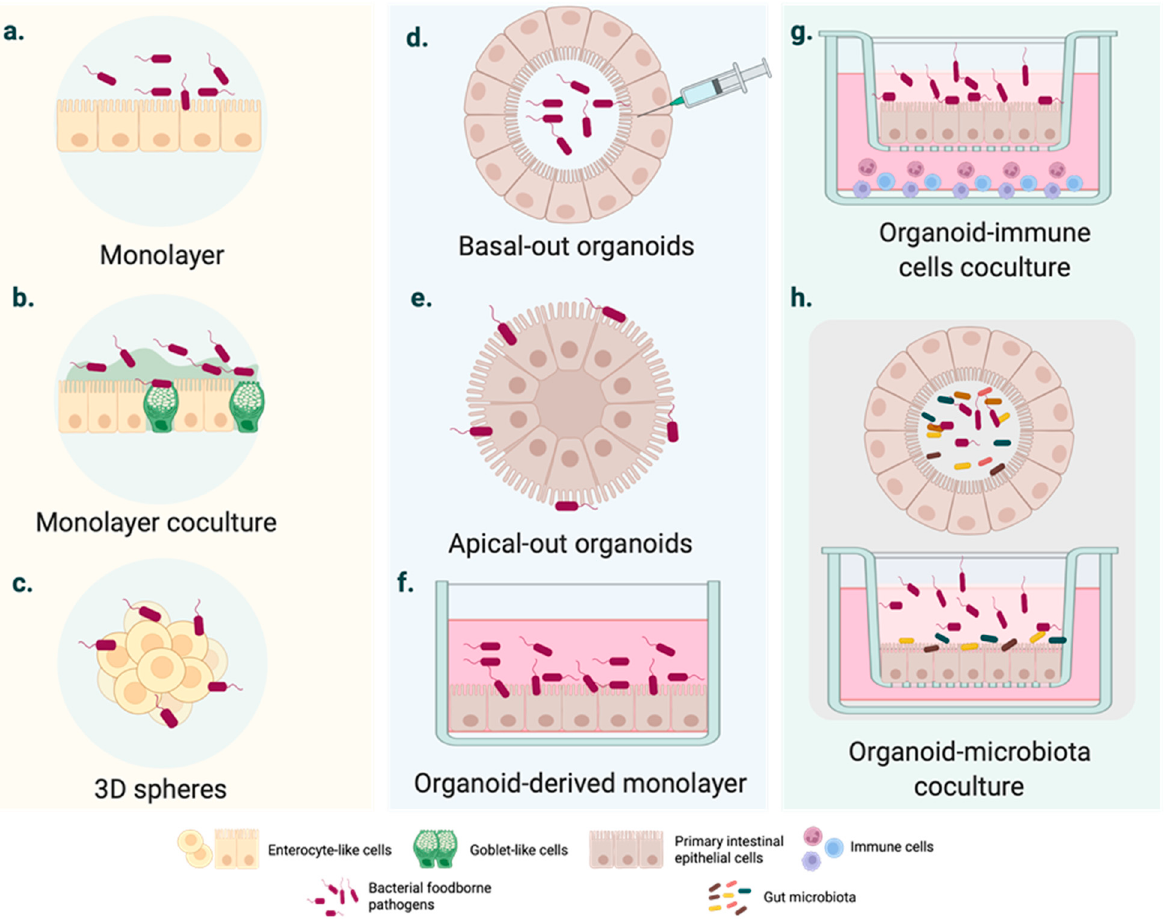
Figure 1. Cell culture systems mimicking intestinal FBD. ( a – c ) Intestinal FBD models derived from immortalized cells. ( a ) Polarized homogeneous cell monolayer typically based on immortalized cell lines with an enterocyte-like phenotype (e.g., Caco-2 cell monolayer). ( b ) Heterogeneous cell monolayer coculturing different cell lines to mimic essential intestinal features, such as the mucus- carrying intestinal tissue (e.g., Caco-2 and HT29 co-culture in vitro cell models). ( c ) 3D cell spheres developed from tumor-derived cell lines. ( d – f ) Intestinal organoid cultures generated from pluripo- tent stem cells (PSCs) or adult stem cells (AdSCs). ( d ) Basal-out organoid. The pathogen is generally injected inside the organoid. ( e ) Apical-out organoids might enhance the access of FBP with a high preference for the apical intestinal compartment. ( f ) Organoid-derived monolayers are D cell infection systems, such as the conventional immortalized cell cultures. ( g – h ) Coculture of intestinal organoids with immune cells and microbiota. More sophisticated organoid-based cultures, including intestinal epithelium–immune system and epithelium–microbiota interactions during